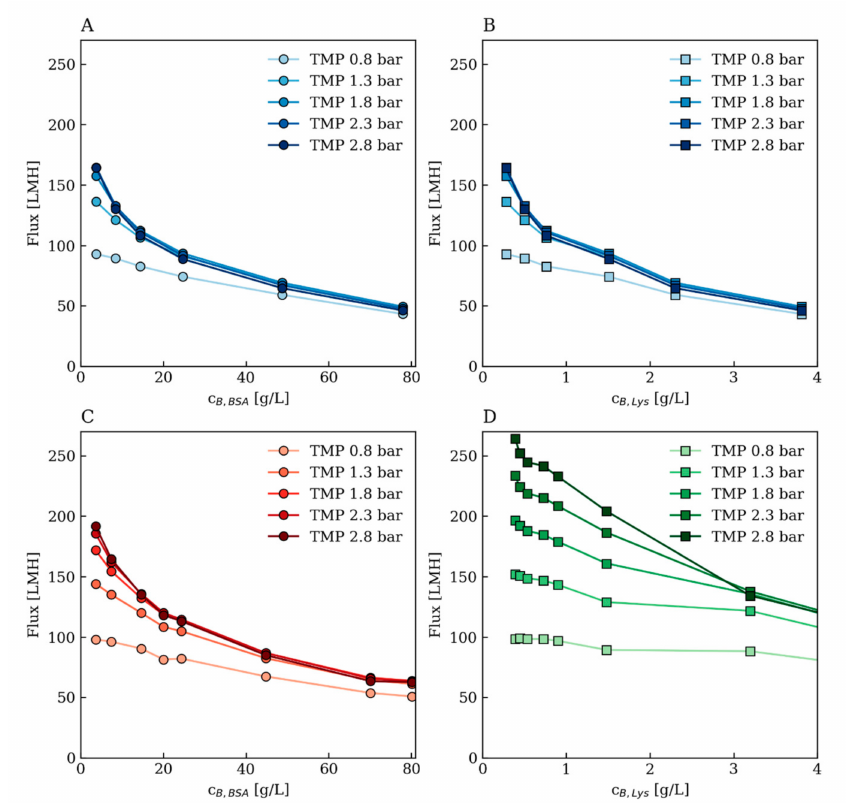
Figure 3. Training data sets including di ff erent protein concentrations and di ff erent TMPs at CF 200 mL / min: two-component training set containing ( A ) BSA and ( B ) lysozyme in the same solution (blue); one-component solution of ( C ) BSA (red) and ( D ) lysozyme